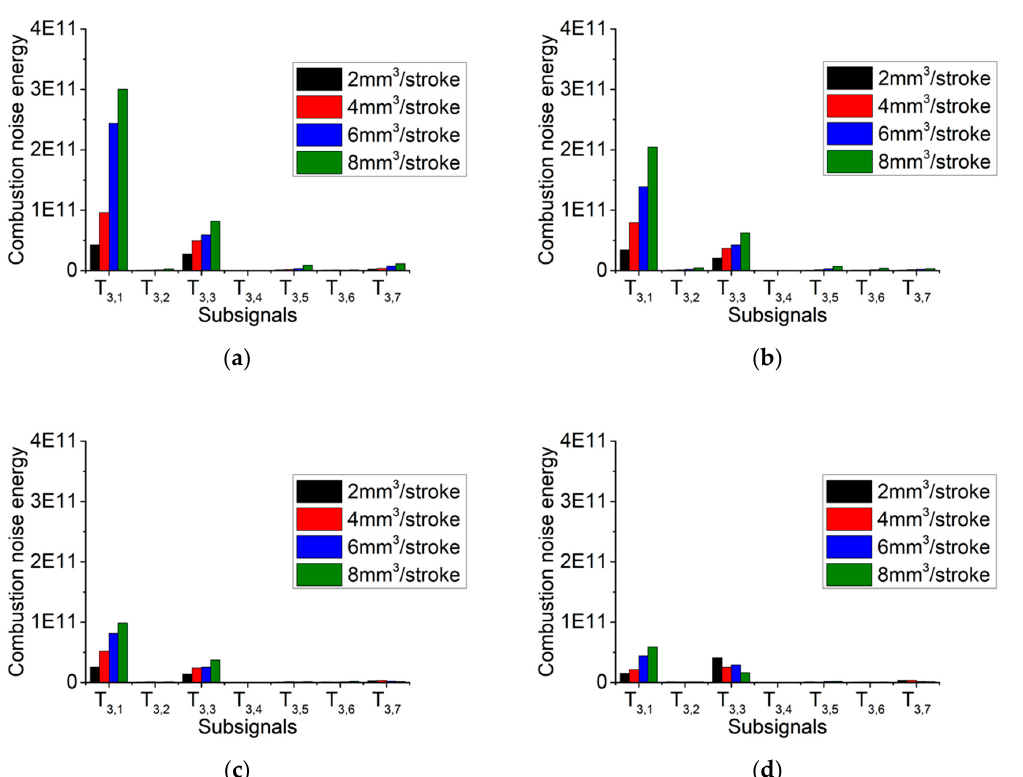
Figure 10. Pilot combustion noise of seven sub-signals. ( a ) Pilot injection timing = − 9° ATDC; ( b ) pilot injection timing = − 14° ATDC; ( c ) pilot injection timing = − 19° ATDC; ( d ) pilot injection timing = − 24° ATDC.